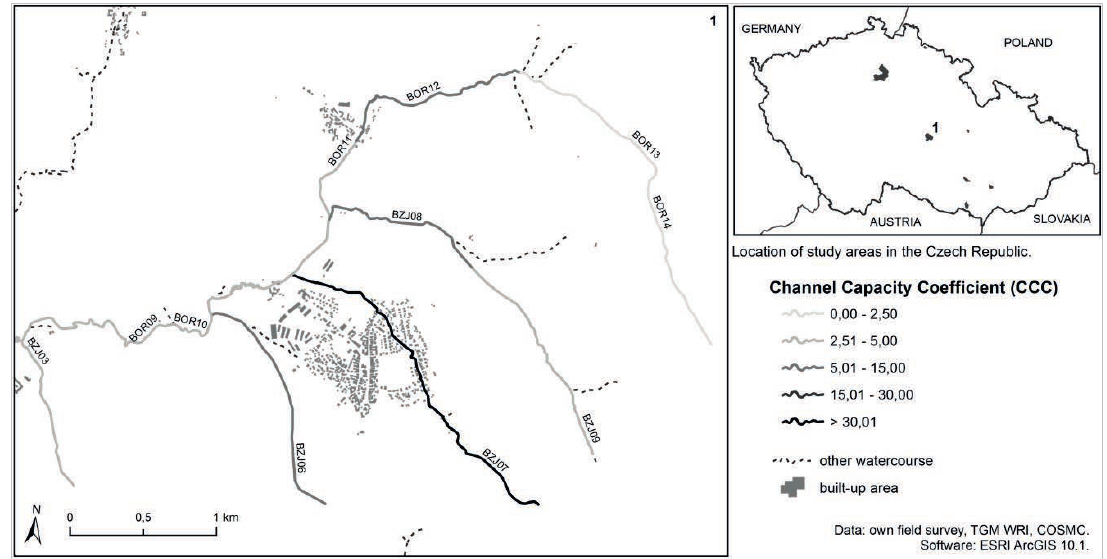
Fig. 2 Spatial variability of the CCC values within the selected section of the watercourse (the Borovsky Brook) and an overview of all interested basins in the Czech